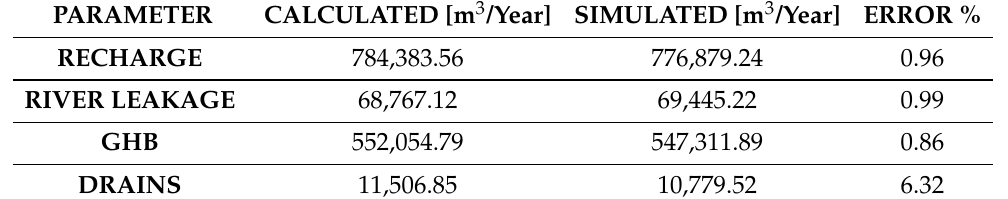
Table 4. Percentage of error for the calibration in steady state of the rainy season.